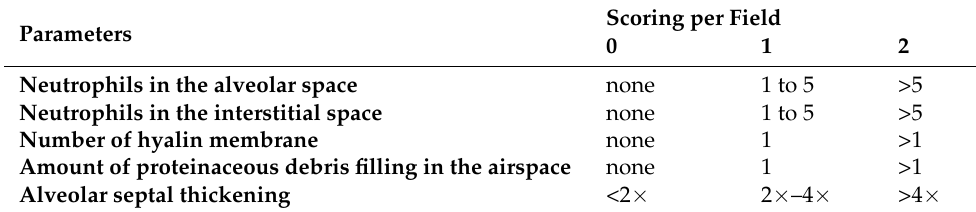
Table 1. Lung injury scoring